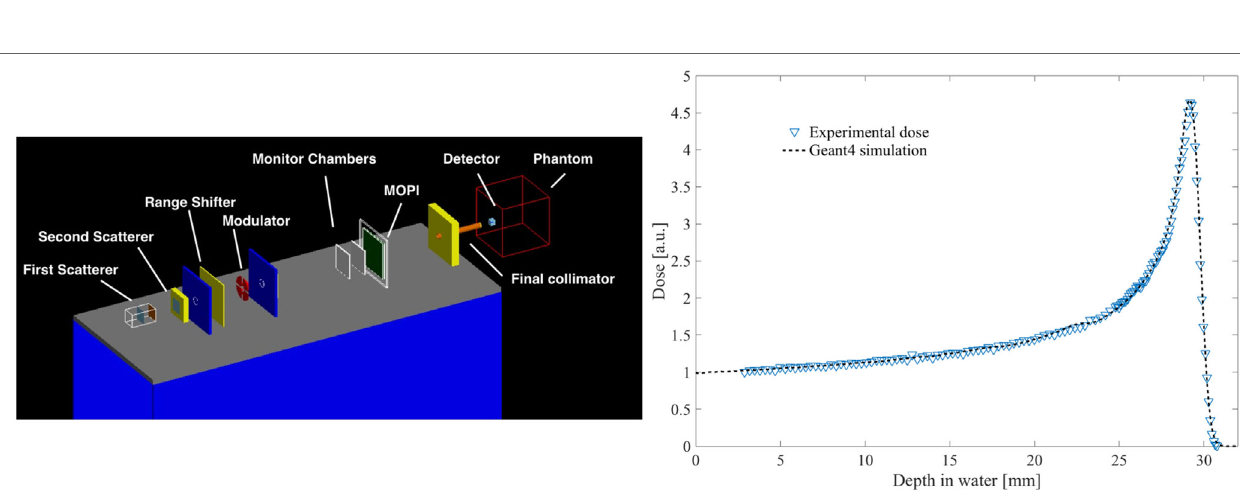
FIgURe 5 | Comparison between simulated and experimental depth–dose distributions with a modulator realized using the new